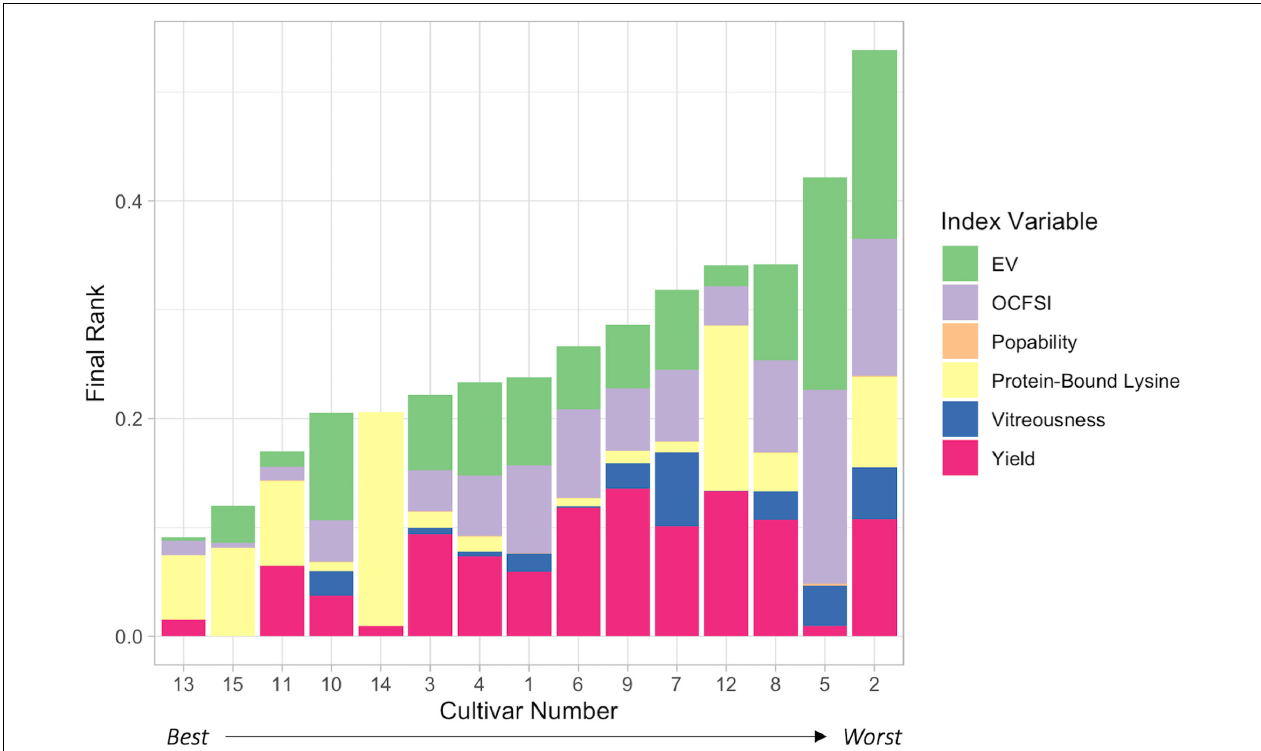
FIGURE 4 | 2020 Ranking System Selection Index Results. Utilization of the 2020 Ranking System enabled a visual display of overall cultivar ranking from best to worst, left to right, respectively. Color by variable identified individual hybrid pitfalls (the longer the stacked column, the farther from the best hybrid) and high trait values. H13, PP1 x PP3, ranked highest out of all hybrids, scoring relatively lower only because of its lack of protein-bound lysine content. QPP H10 ranked the best compared to all other QPP lines and ranked higher than H14, or Commercial Line 1. QPP BC 2 -derived hybrids H3, H4, and H1 ranked, respectively, higher than the rest, while BC 3 -derived hybrids H6, H9, and H7 all ranked higher than original popcorn hybrid line H12. H8, H5, and H2 ranked lowest out of all hybrids. Economic weights for each trait were determined to reflect consumer and producer interests in a ready-to-eat Quality Protein Popcorn product. Lysine levels, yield, and expansion volume were considered equally important traits while ranking all